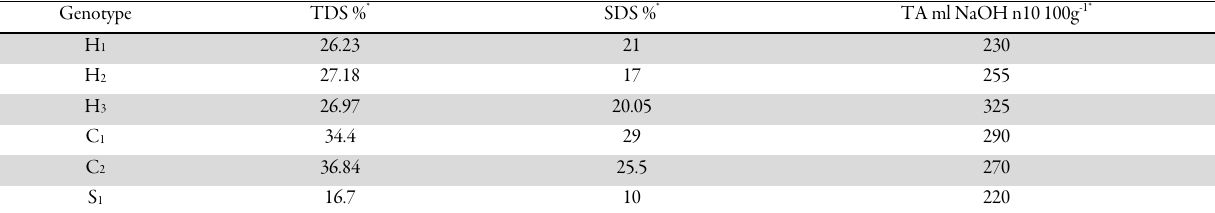
Table 5. Characteristics on chemical composition in genotypes of the selected genotypes